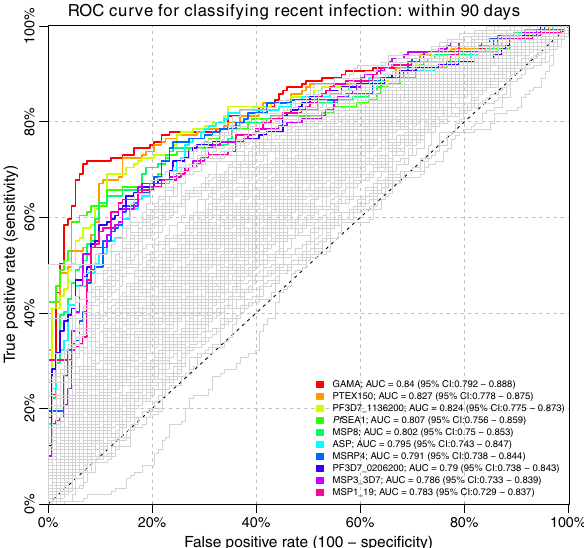
Fig. 3 Receiver operating characteristic (ROC) curve for classifying individuals as infected within 90 days using a threshold antibody level to a single antigen. Coloured curves correspond to the top 10 antibody responses that were most accurate in detecting recent infection as determined by the classi fi er area under the ROC curve